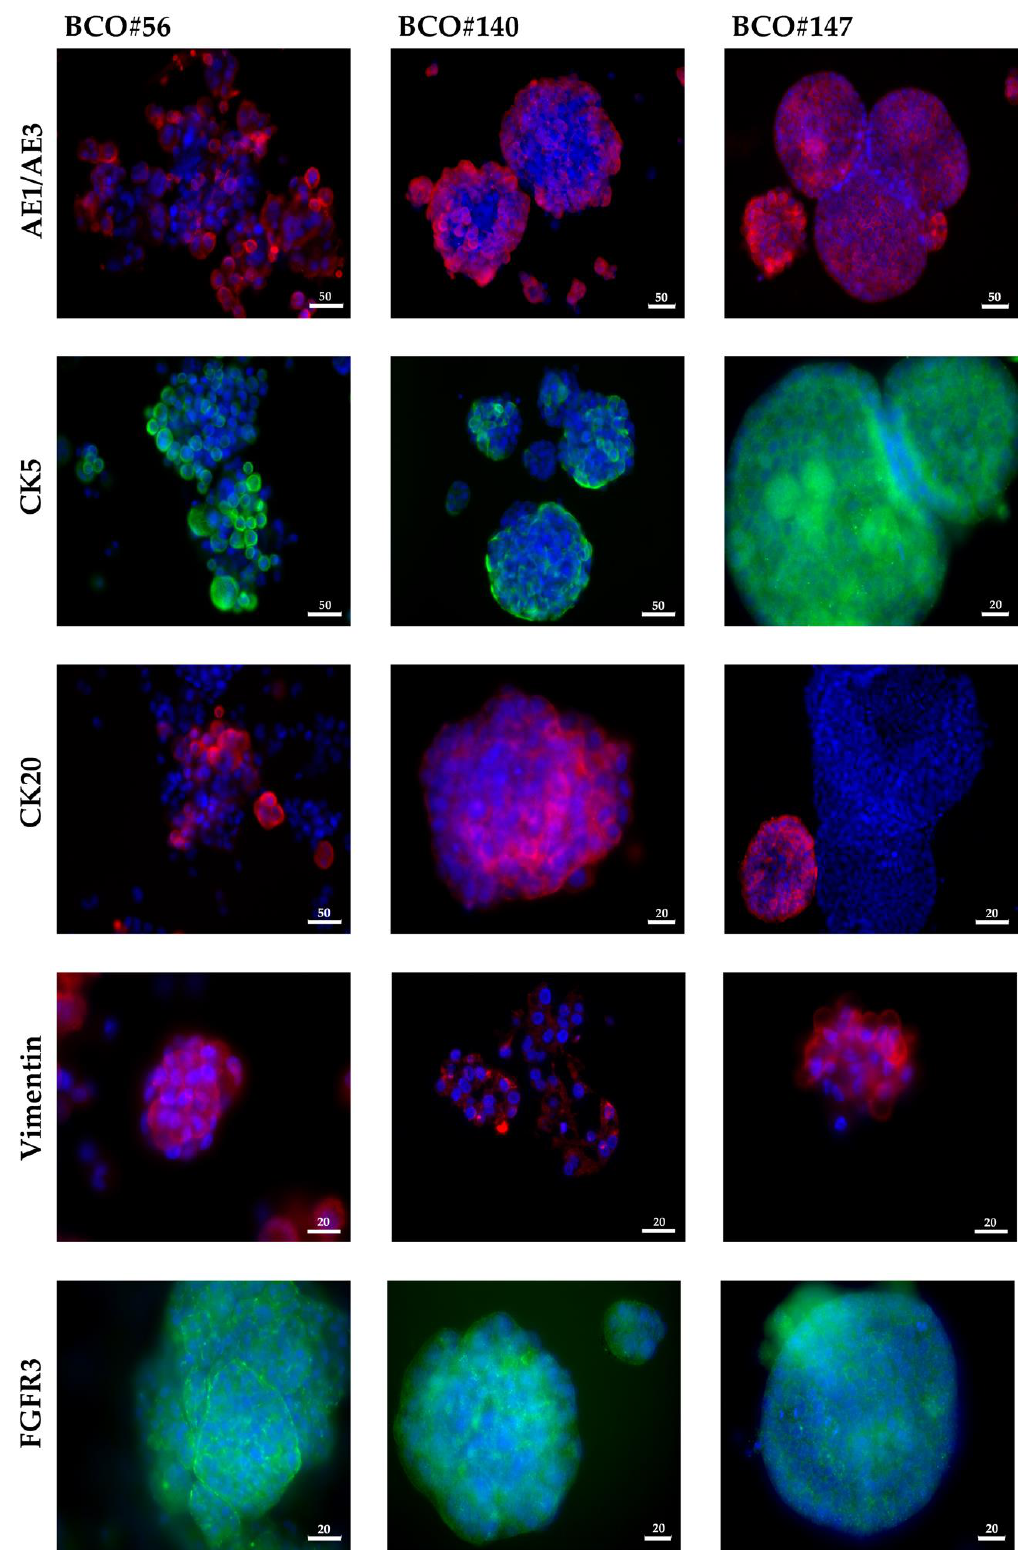
Figure 2. Characterization of urothelial organoids by immunofluorescence. Organoids were fixed and stained by antibodies to epithelial and urothelial lineage markers, i.e., cytokeratins AE1/AE3, CK5, and CD20 as indicated. In addition, expression of the mesenchymal antigen vimentin and of fibroblast growth factor receptor 3 was investigated. Size bars indicate 20 µ m or 50 µ m as